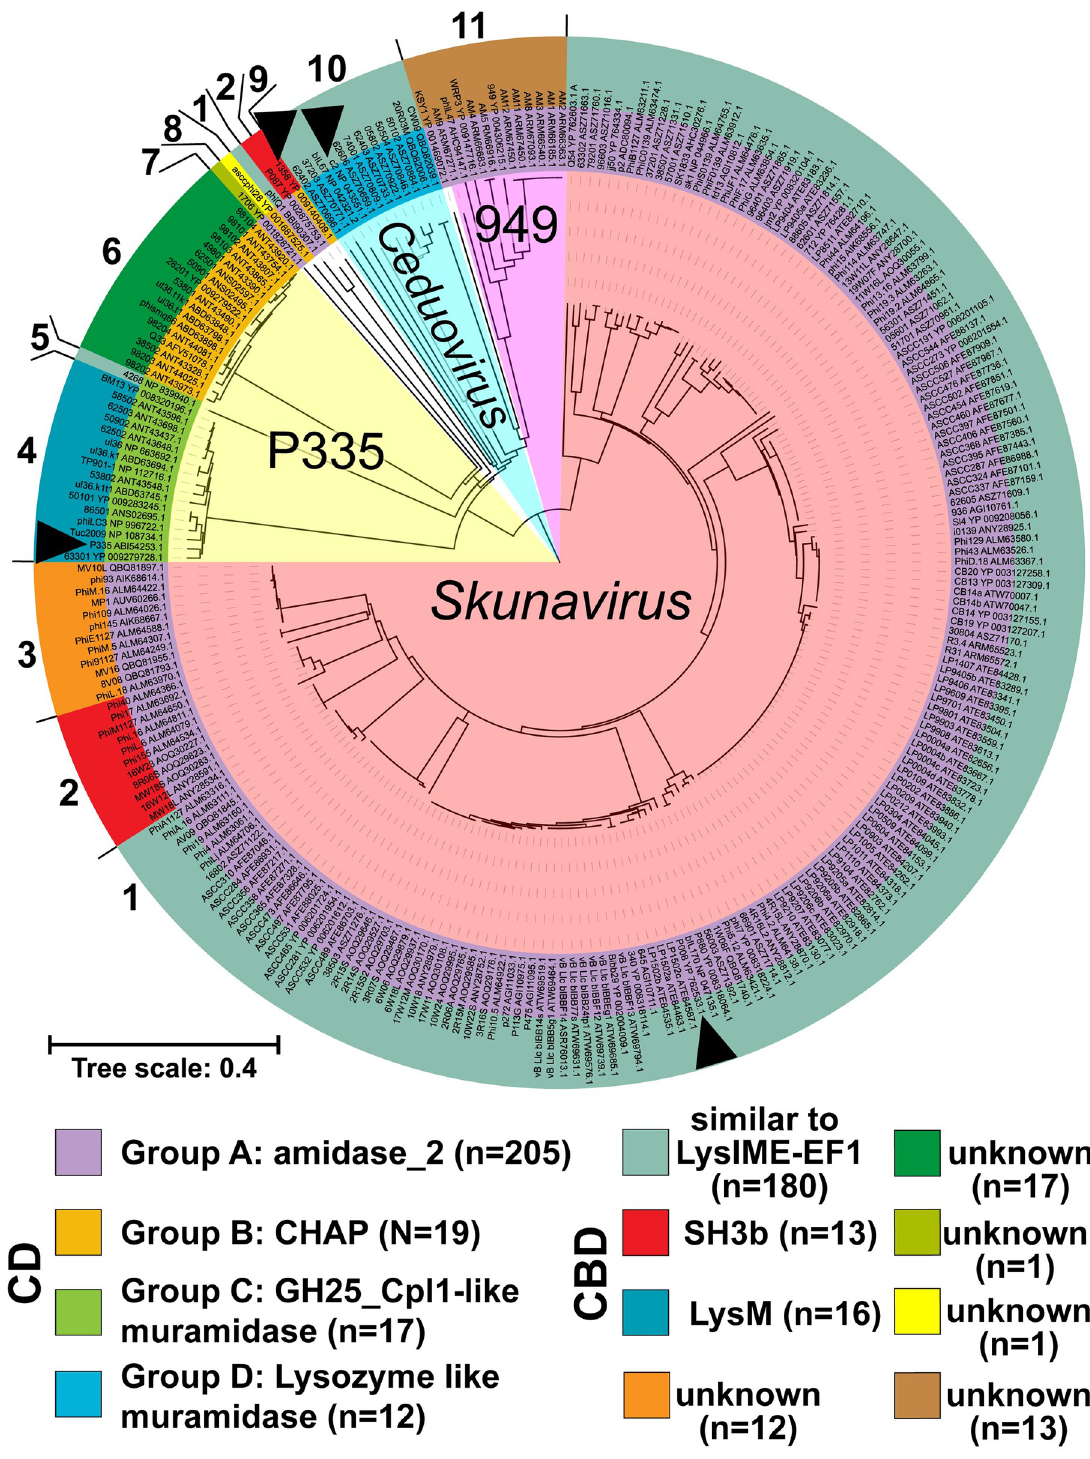
Fig 1. Phylogenetic relationship of endolysins of phages infecting Lactococcus lactis . The diversity of endolysins from 253 complete lactococcal phage genomes was investigated. We used ClustalW (v2.1) to perform multiple alignments and generate a phylogenetic tree (S1 Data). Conserved CDs and CBDs were determined based on HHPred and BLASTP predictions. The 253 endolysins were classified into 4 groups according to their CDs and are represented by different colors. Each phage is followed by the accession number of its respective endolysin. The phage taxonomic status is indicated when more than 1 species/genus is represented. CBD AU : AbbreviationlistshavebeencompiledforthoseusedinFigs 1 ; 2 ; 5 ; 6 ; and 8 : Pleaseverifythatallentriesarecorrect : , cell wall–binding domain; CD, catalytic domain. https://doi.org/10.1371/journal.pbio.3001740.g001 PLOS Biology | https://doi.org/10.1371/journal.pbio.3001740 August 1,